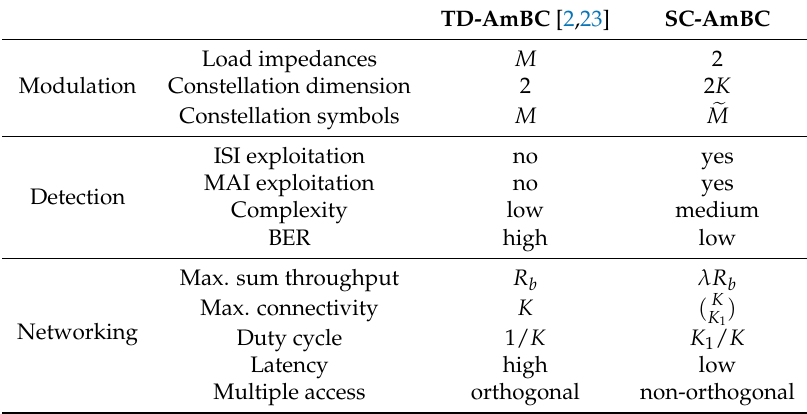
Table 2. Comparison of the conventional TD-AmBC and the proposed